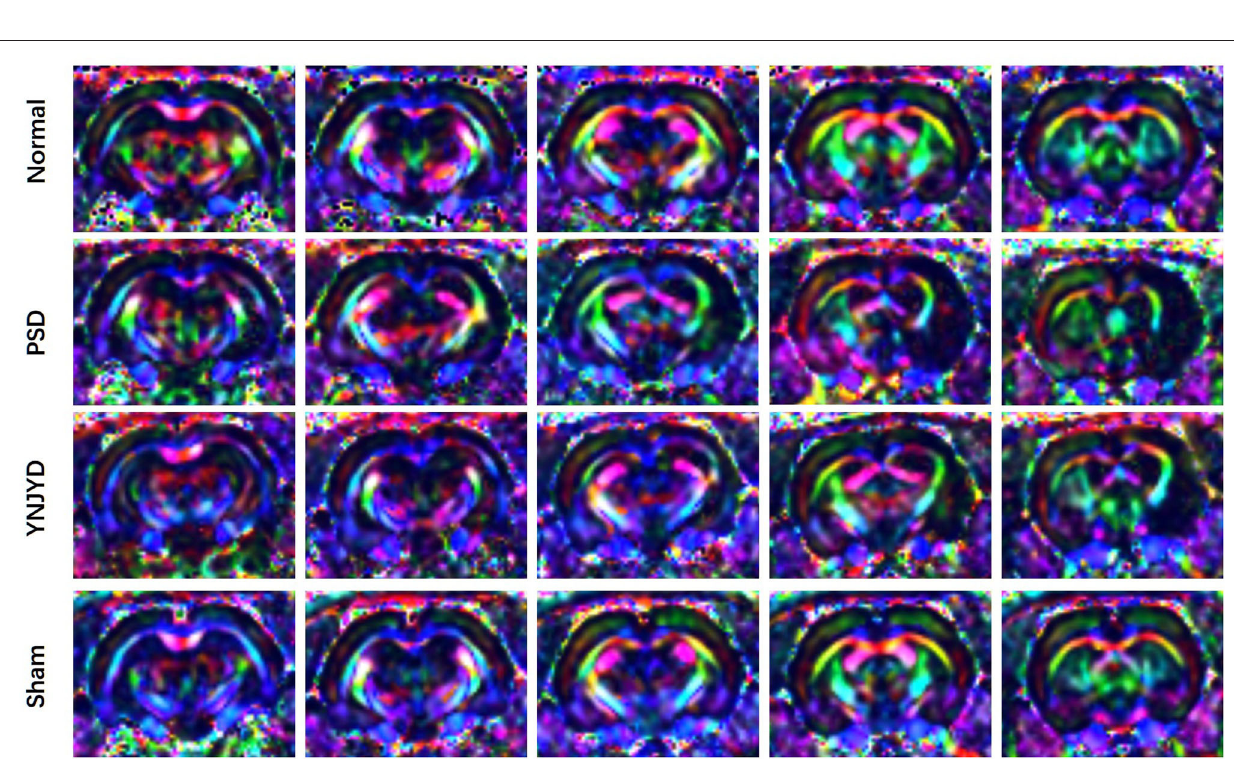
Frontiers in Psychiatry |